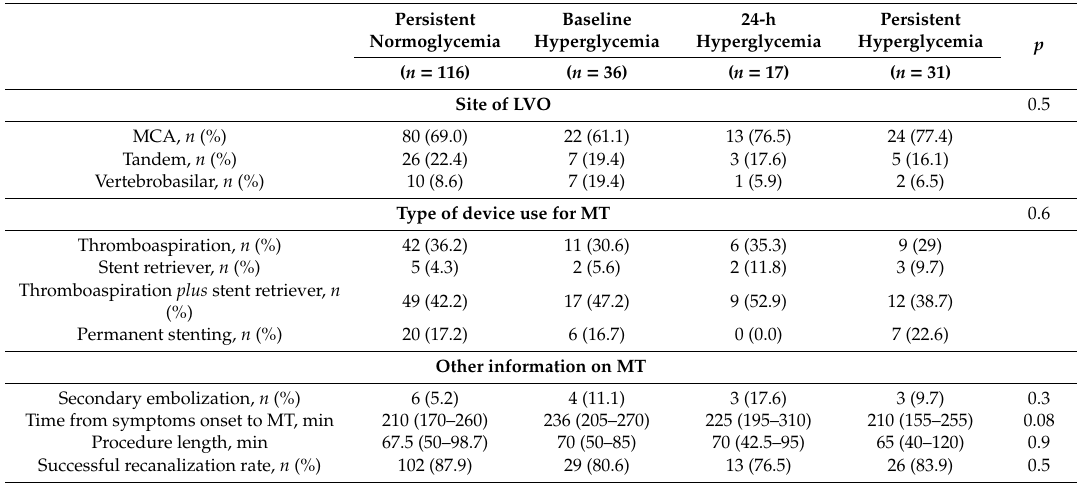
Table 2. Information on mechanical thrombectomy, according to the hyperglycemic patterns.